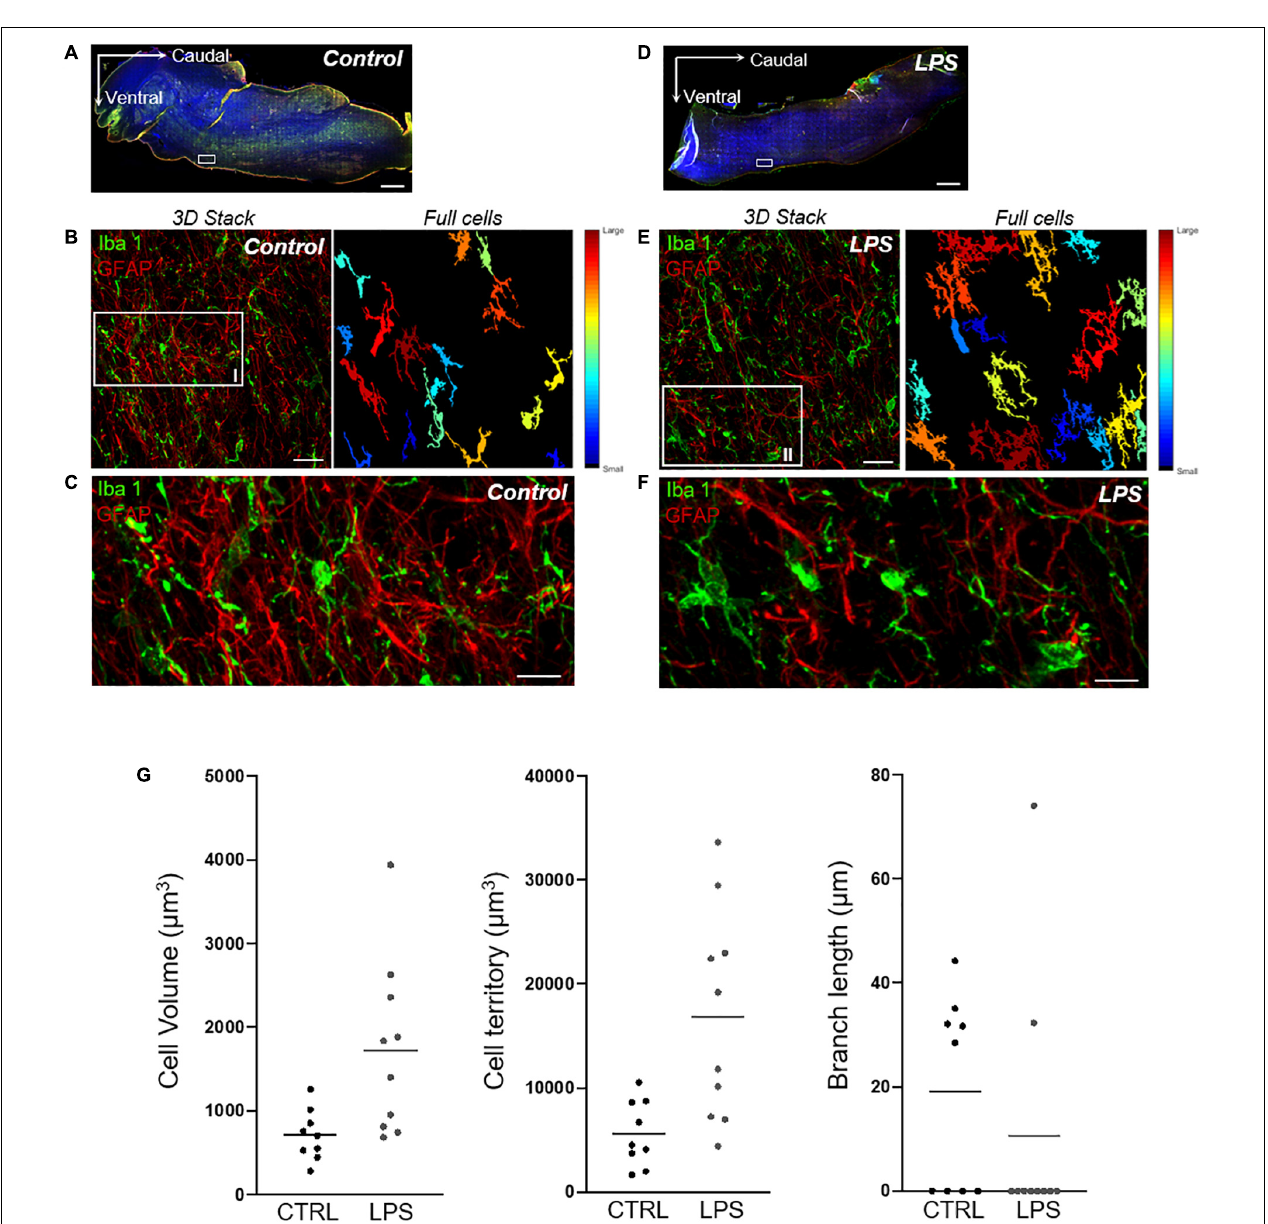
FIGURE 7 | Quantitative analysis of microglial-cell morphology in the rostral ventrolateral region of the medulla. (A,D) Axioscan images of whole brainstem (AxioScan.Z1scanner, Carl Zeiss, Zaventem, Belgium) showing targeted areas from the rostral ventrolateral region of the medulla (white boxes) in one control (left) and one LPS-injected (right) lamb. Scale bar: 1000 µ m. (B,E) Example of a 3D confocal image stack with full-cell segmentation automatically generated by 3DMorph MATLAB-based script showing how quantitative morphological analysis of microglial cells (Iba1-positive cells, green) is performed. The full-cell segmentation shows remaining microglial cells after exclusion of partial cells and small processes not related to a cell body. Scale bar: 35 µ m. (C,F) High magnification of the same medullary areas allows for appreciation of the morphological changes of the activated microglial cells in the LPS-injected lamb compared to the resting state in the control lamb. Qualitative analysis thus reveals a higher number of microglial cells with a larger cell-body surface, a larger total territory occupied by microglial cells, and shorter branch length in the LPS-injected lamb. Meanwhile, qualitative assessment of astrogliosis (GFAP-positive cells, red) does not suggest differences between the LPS-injected and the control lamb over the same medullary regions. Scale bar: 10 µ m. (G) 3DMorph quantitative analysis of microglial-cell morphology from the above images (C,F) shows an increased average cell volume and territorial volume, as well as smaller branch length in the LPS-injected compared to the control